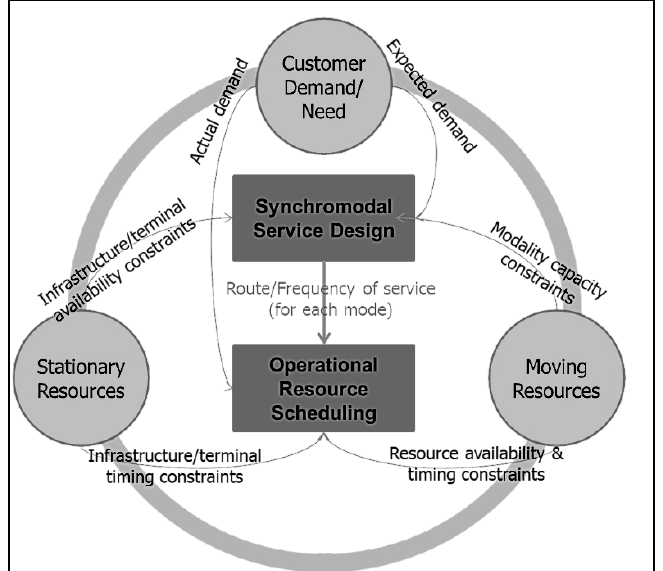
Figure 5. Different synchromodal requirements for different decision problems